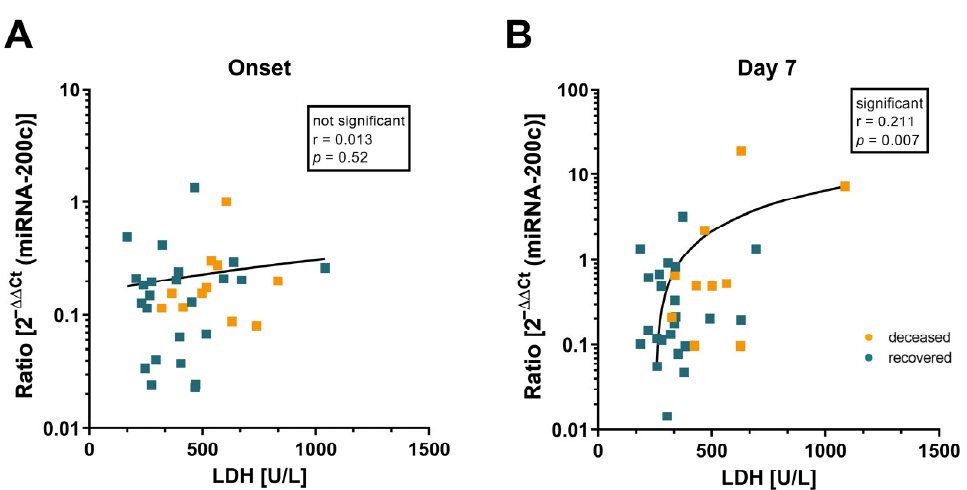
Figure 4. Correlation between miRNA ‐ 200c and LDH. Scatter plots of Spearman correlation analysis show the correlation between miRNA ‐ 200c and LDH at onset ( A ) and day 7 ( B ). Color ‐ coded values indicate a fatal or non ‐ fatal course of infection for the patient.